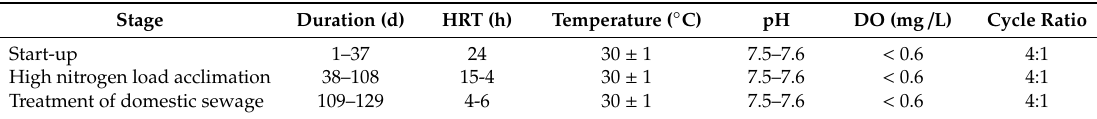
Table 2. Operating conditions of the